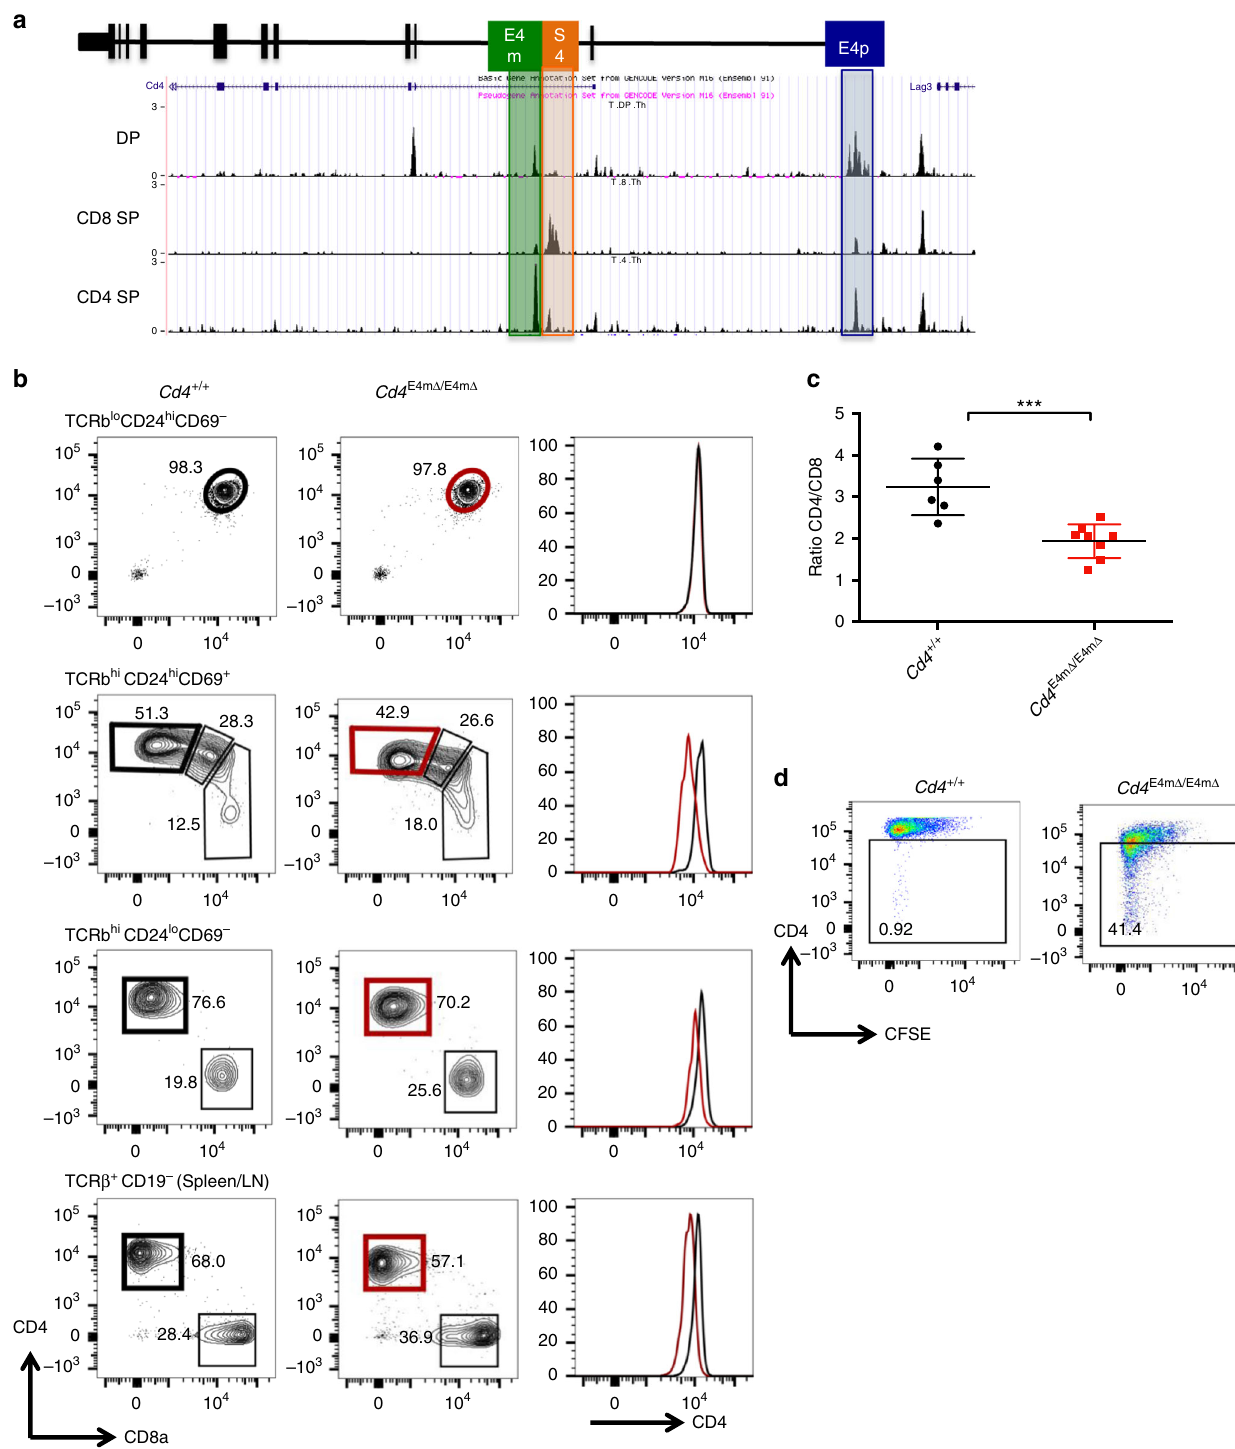
CD8 + T cells in the periphery as compared to wild-type (WT) total number of thymocytes between WT and KO mice CD4 + T cells from Cd4 E4m Δ /E4m Δ and control mice in vitro Cd4 E4m Δ /E4m Δ cells (Fig. 1d), signifying that E4m is